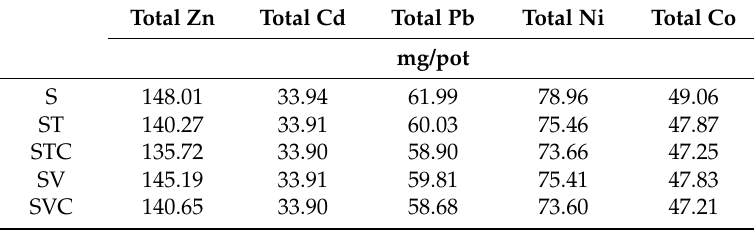
Table 3. Total mass (mg) of metals in soil per pot in each treatment after contamination of the soil.